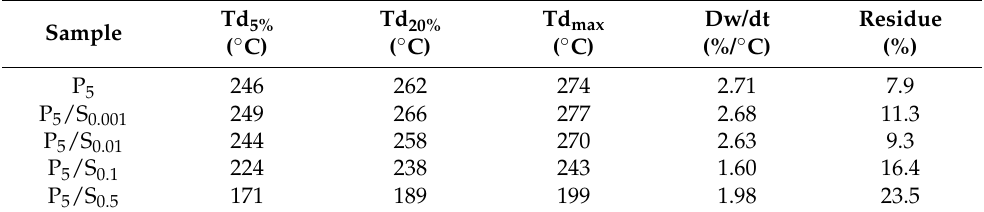
Table 3. TGA (thermogravimetric analysis) data of freeze dried PVA and PVA/NaOH